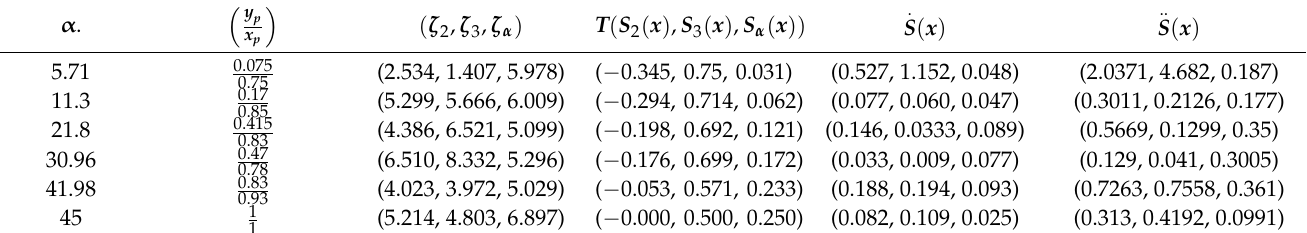
(cid:0) (cid:1) x p , y p is located in the first right